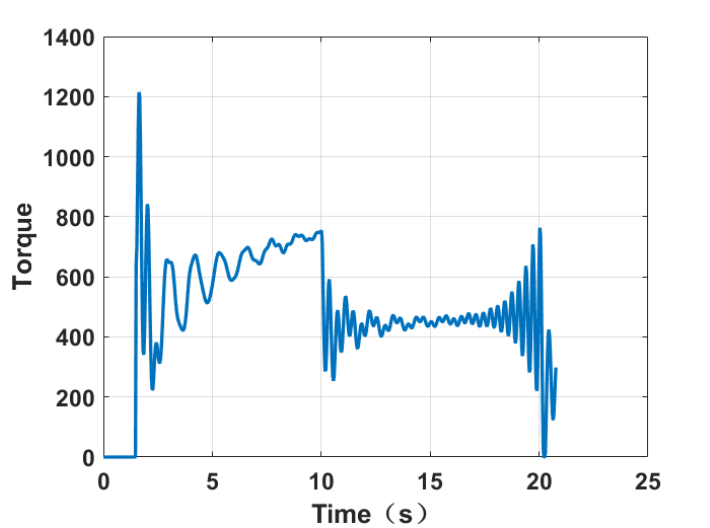
Figure 13. Brake torque curve on hybrid